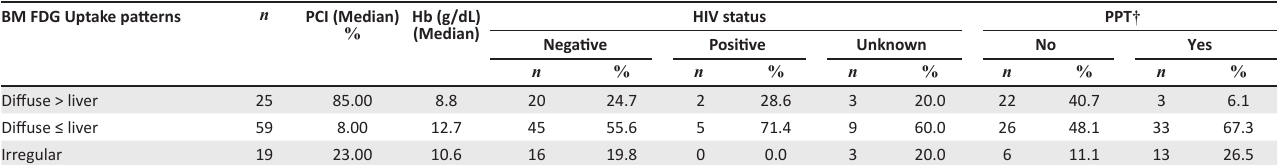
TABLE 2: Summary of results. BM FDG Uptake